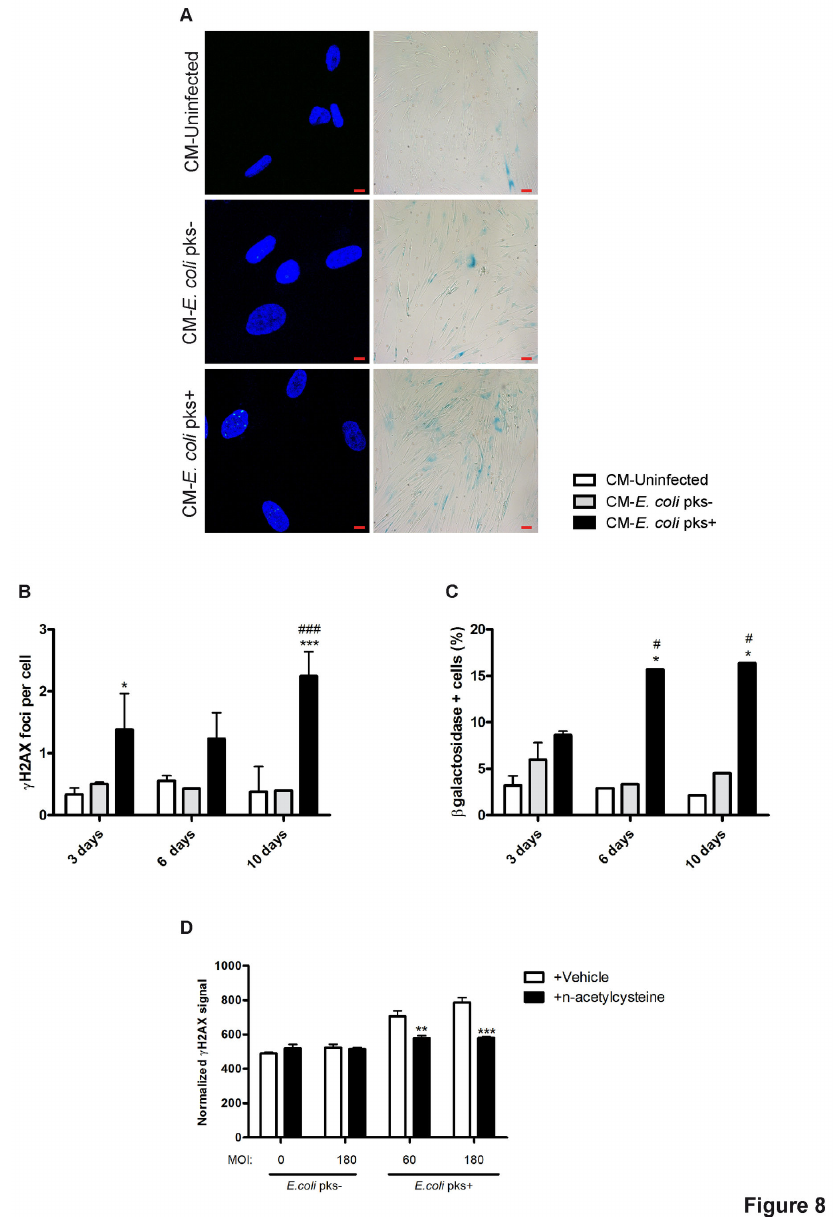
Figure 8. Pks+ E. coli infected IMR-90 cells induce bystander γH2AX foci formation and SA-β-Gal expression in uninfected IMR-90 cells. Naïve IMR-90 cells were treated for 1 day (γH2AX) or 3 days (SA-β-Gal) with conditioned media (CM) prepared 3-6-10 days after infection with pks + or pks - E . coli with a MOI 180 (A, left panel). Cells were treated for 24 h with a 6 days-old CM and examined for DNA (Blue) and γH2AX (green), scale bars = 10µm (A, right panel). Cells were treated for 3 days with a 6 days old CM and examined for SA-β-Gal staining (Blue) (x20 magnification) (B) Numbers of γH2AX foci per cell (B) and percentages of SA-β-Gal positive cells (C) were quantified as before, 30-100 nuclei or 100-200 cells were evaluated for each condition. Results represent the mean and SEM of two independent experiments, one-way ANOVA with Bonferroni’s multiple comparison test; *P<0.05, ***P<0.001 comparing infected and uninfected groups; #P<0.05, # # #P<0.001 comparing pks + and pks - groups. (D) IMR-90 grown on Transwells, were infected for 4h with live pks + or pks - E . coli , washed and grown with gentamicin for 3 days. The Transwells were then transferred on top of naive IEC-6 cells and incubated for 24 hours with or without n-acetylcysteine (1mM). The IEC-6 cells were fixed and γH2AX was quantified by In-Cell Western. Results represent the mean and SEM of one experiments including triplicates for each conditions, two-way ANOVA with Bonferroni’s multiple comparison test; **P<0.01, ***P<0.001 comparing vehicle and n-acetylcysteine groups. doi: 10.1371/journal.pone.0077157.g008 PLOS ONE |